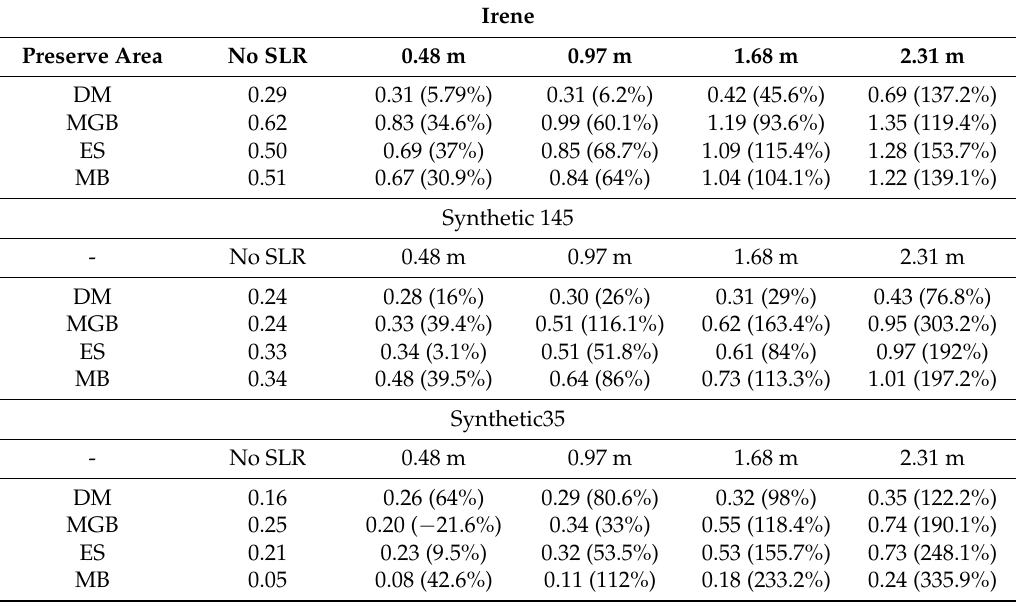
Table A5. Modeled data showing the maximum wave heights for each Preserve Area. The percent increase in wave heights is shown in parenthesis.